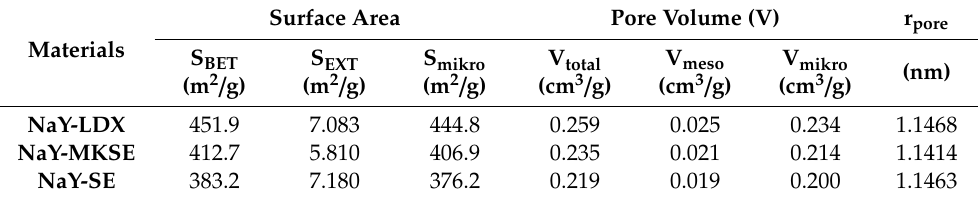
Table 4. The surface area analysis results of the as-synthesized NaY preparations.